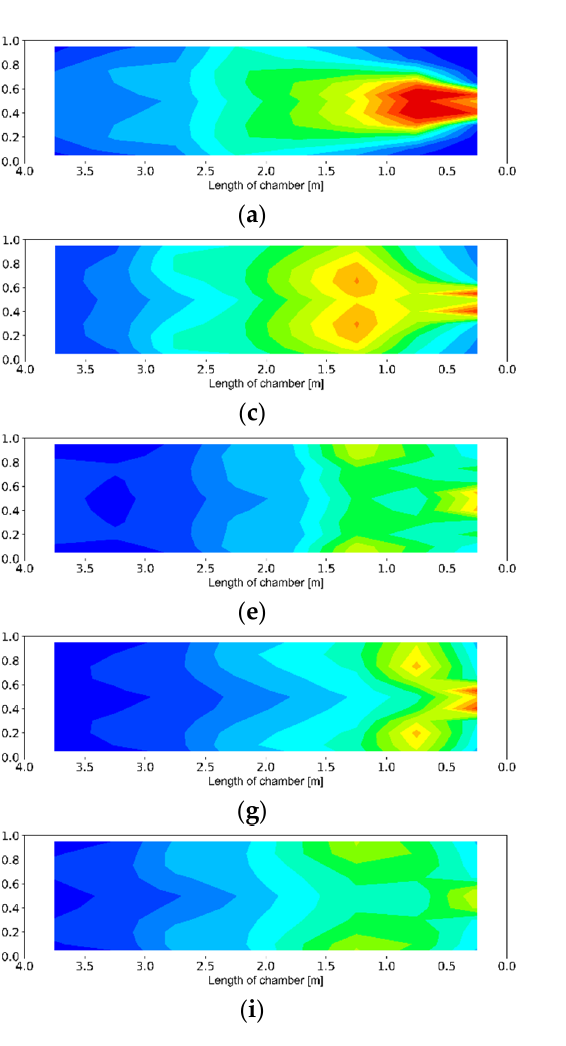
Figure 9. Influence of inert gas addition on flame temperatures—burner with staged air distribu- tion—Burner B: ( a ) primary regime without inert gas addition; ( b ) secondary regime without inert gas addition; ( c ) primary regime with the addition 30 m N3 /h of N 2 ; ( d ) secondary regime with the addition 30 m N3 /h of N 2 ; ( e ) primary regime with the addition 60 m N3 /h of N 2 ; ( f ) secondary regime with the addition 60 m N3 /h of N 2 ; ( g ) primary regime with the addition 30 m N3 /h of CO 2 ; ( h ) sec- ondary regime with the addition 30 m N3 /h of CO 2 ; ( i ) primary regime with the addition 60 m N3 /h of CO 2 ; ( j ) secondary regime with the addition 60 m N3 /h of CO 2 .